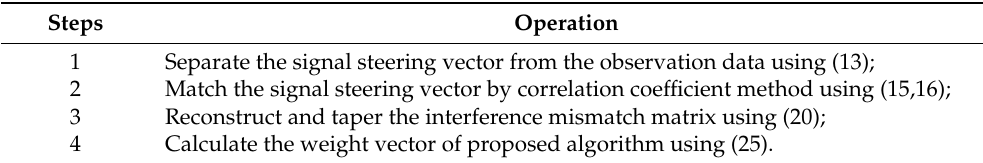
Table 1. The detailed steps for implementing the proposed